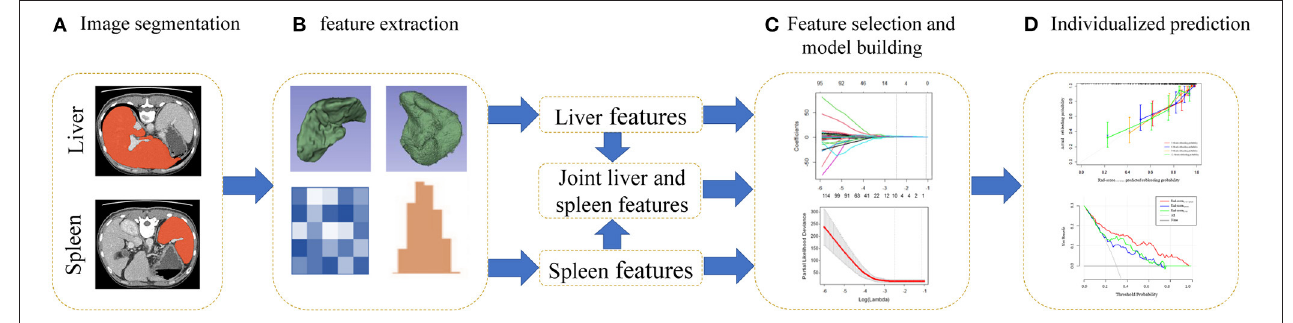
FIGURE 2 | Flowchart for the radiomics analysis. (A) Regions of interest (ROIs) of the liver and spleen were segmented manually on all axial slices. (B) Three-dimensional reconstruction, texture analysis and feature extraction of ROIs. (C) For feature selection, the least absolute shrinkage and selection operator (LASSO) Cox method was used. A radiomics score was generated by a linear combination of selected features. (D) Calibration curves and decision curve analysis (DCA) were utilized to evaluate the Rad-score Liver − Spleen .